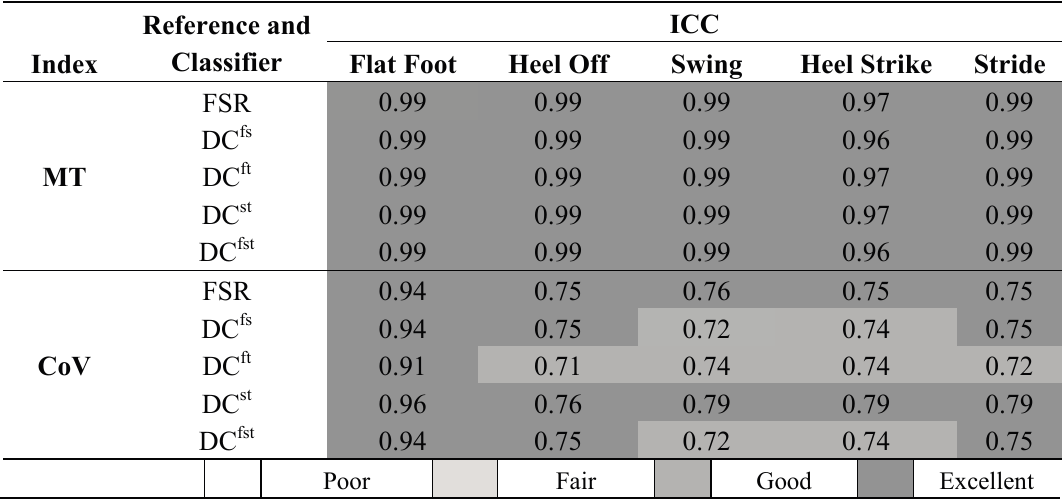
Table 4. Values of ICC for Mean Time ( MT ) and Coefficient of Variation ( CoV ) evaluated for stride and each gait phase for FSR and